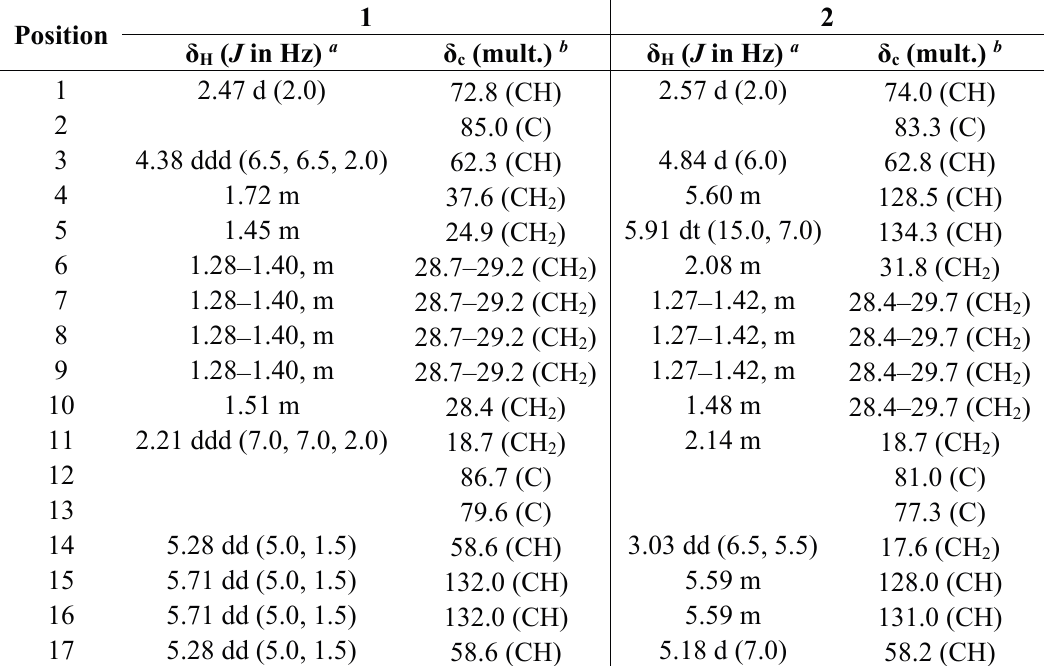
Table 1. 1 H and 13 C NMR data for 1 and 2